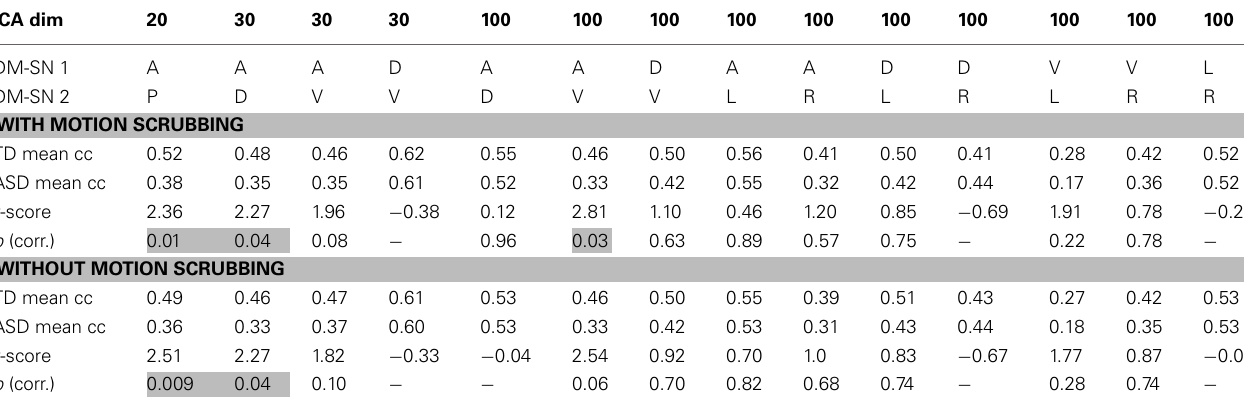
Statistically significant differences between the ASD and TD groups are denoted with a gray cell background. Abbreviations of the DM-SNs: A, Anterior; P,